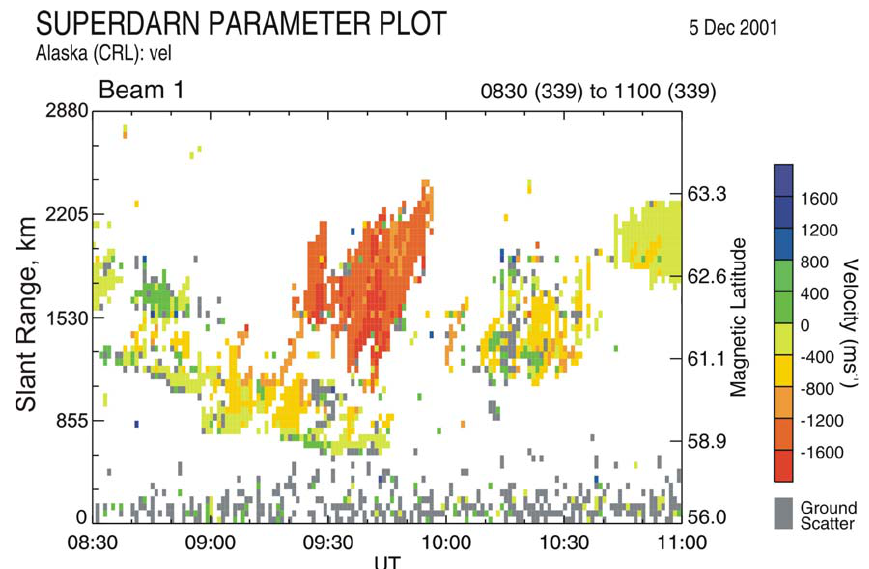
Figure 4. Echo Doppler velocity in beam 1 of the King Salmon radar for 5 December 2001, 08:30-11:00 UT in range (ACCGM magnetic latitude) – universal time coordinates.